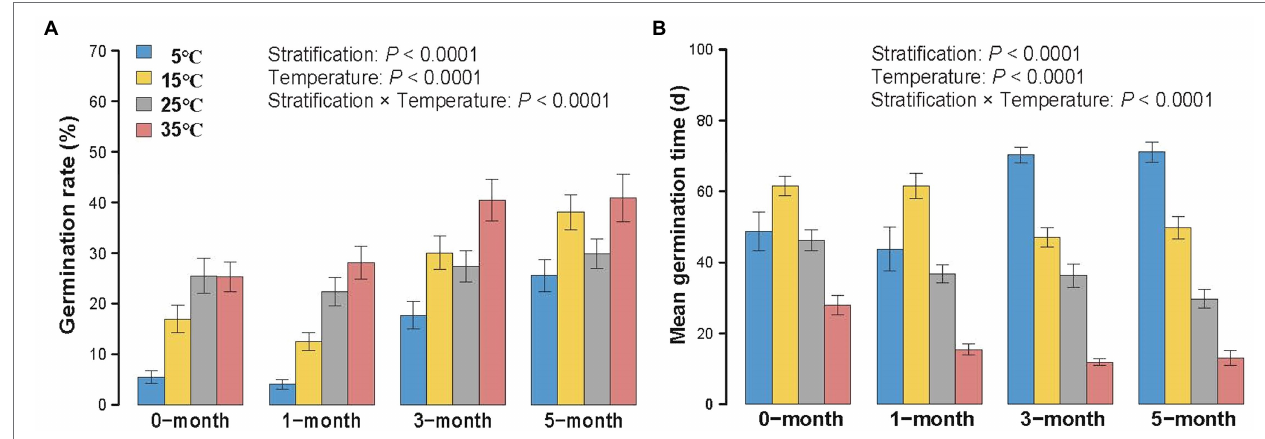
FIGURE 3 | Variation of germination rate (A) and mean germination time (B) of 0/1/3/5-month-stratification Spartina alterniflora seeds under different temperatures (5 ° C–35 ° C). Values indicate means ± 1 SE.